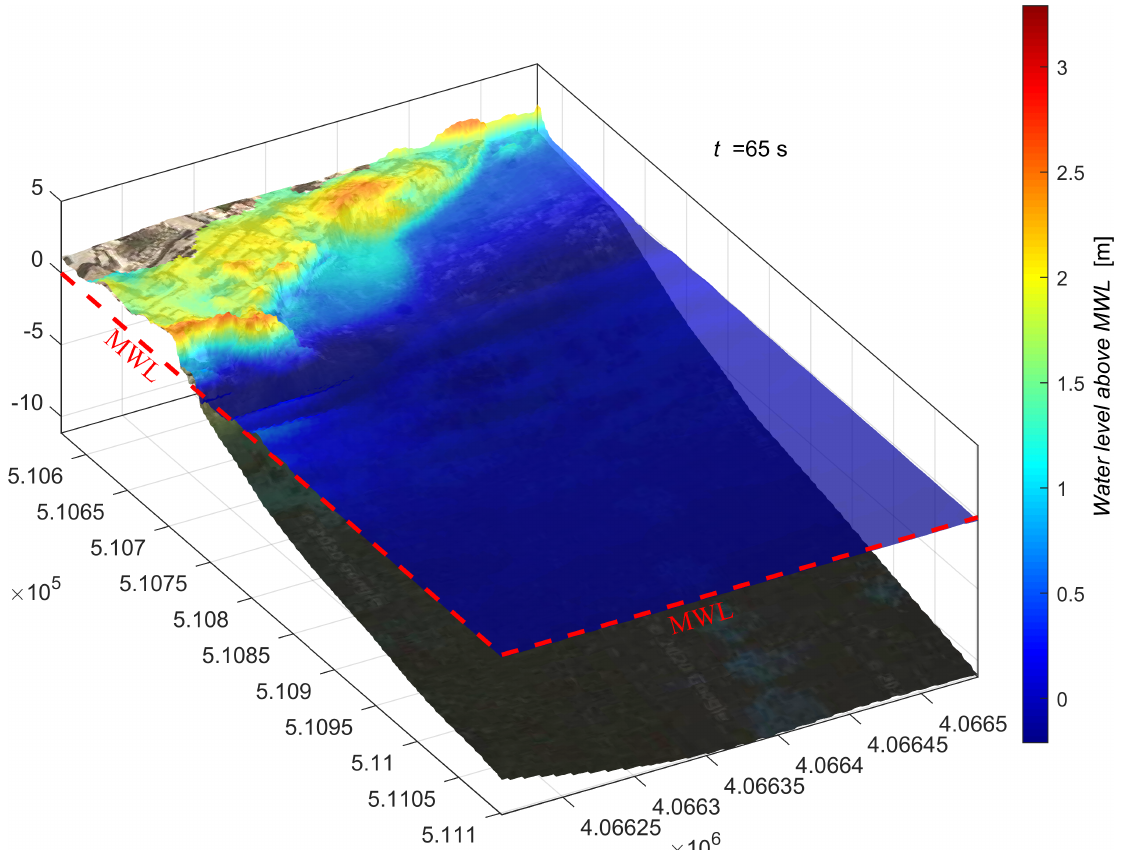
Figure 12. Magnification of subplot (f) of Figure 11. The red lines shows the MWL the color bar shows the water level above the